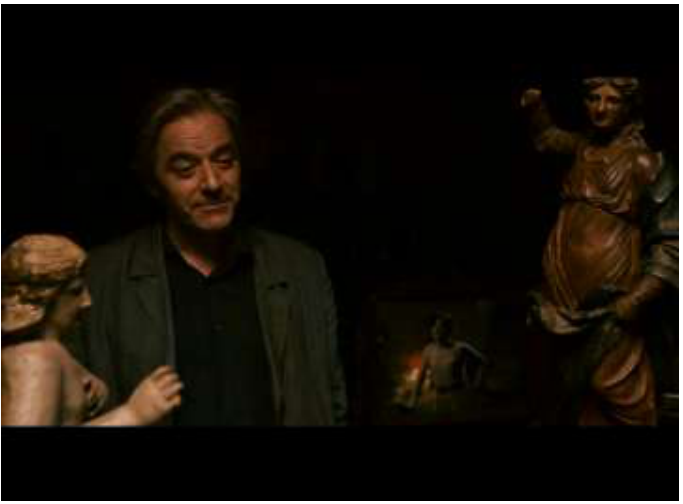
Figure 1: In this scene, set in Elle‟s dark basement antique shop, James is tightly framed between the very objects he claims to keep his distance from—antiques. An interest in such antiques, he says, can be dangerous, and in this shot, he is literally boxed in by them, as is Elle. Here, he holds a conversation with Elle‟s miniaturized reflection, reinforcing the idea that we may never really know a person, except through individual perspective. He does not and cannot see the real Elle, only a reflection of